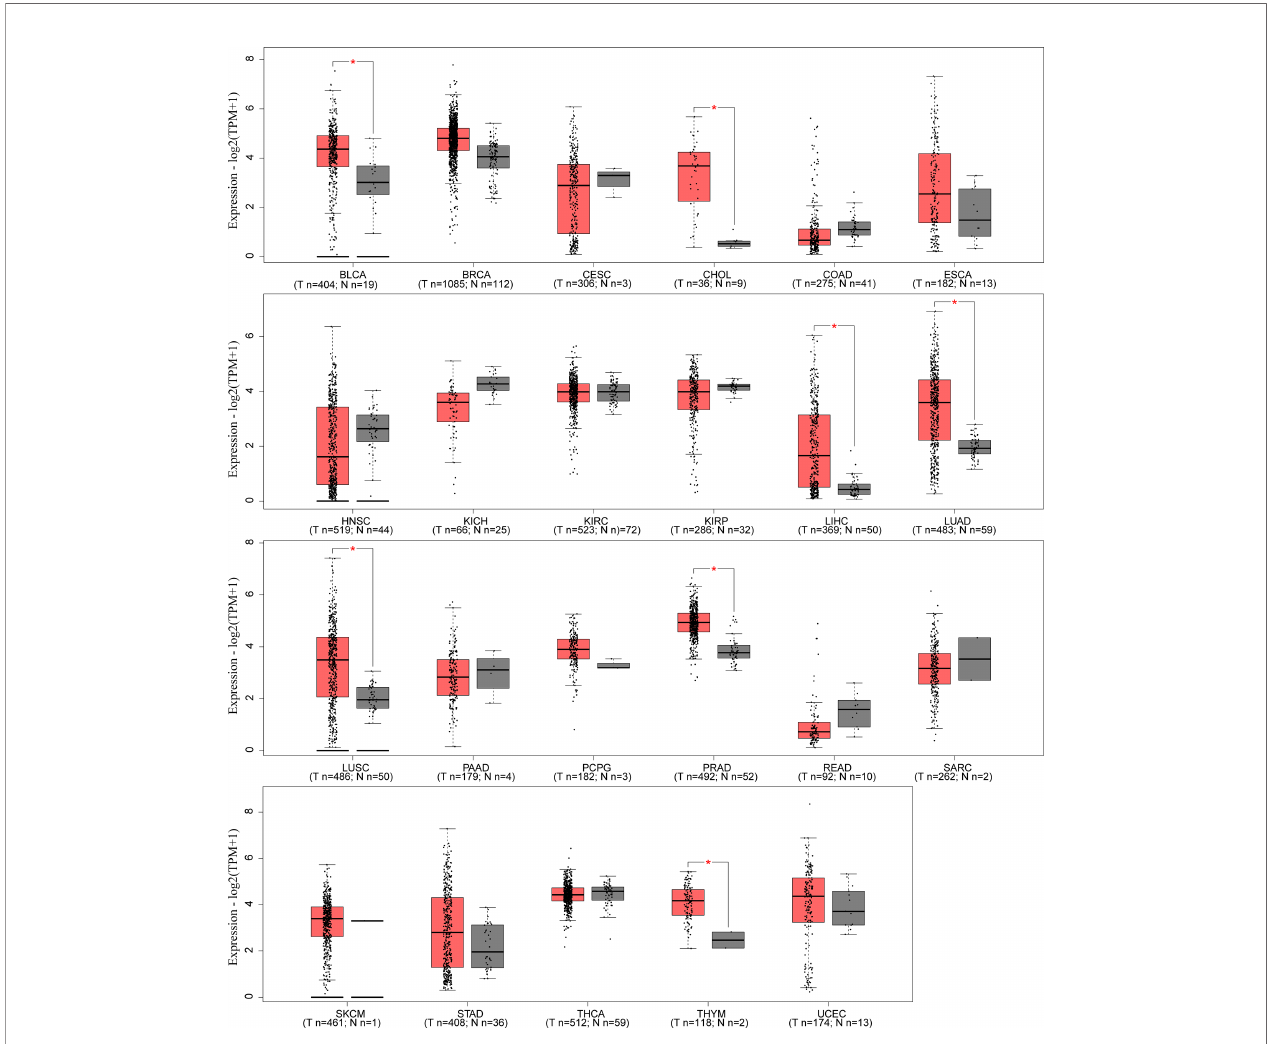
FIGURE 4 | LINC00665 expression in human cancers and corresponding normal tissues (data from TCGA). * p <